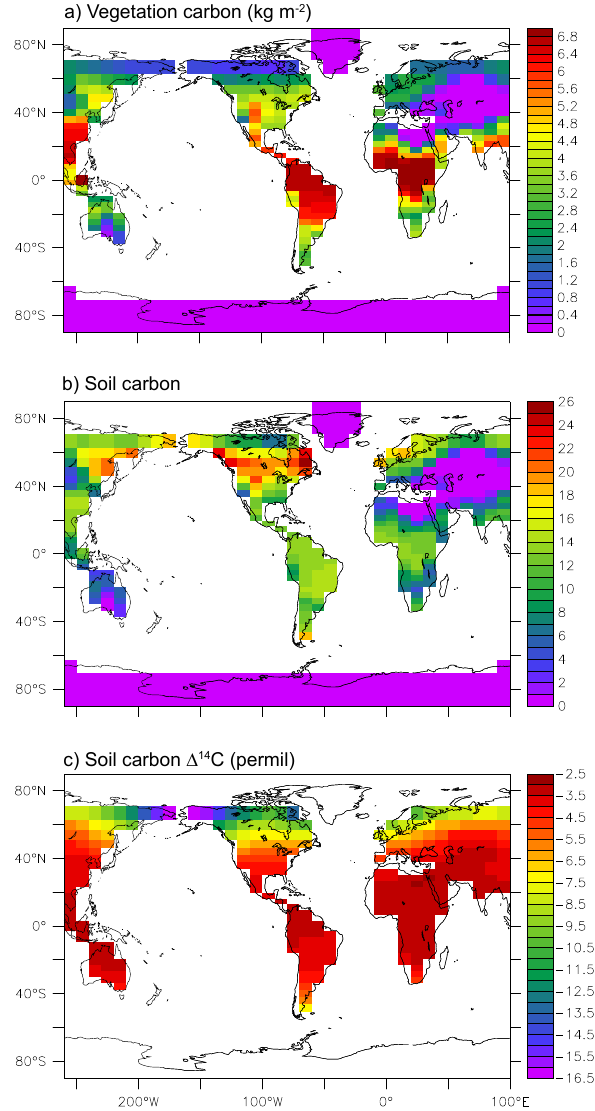
Fig. 12. Simulated annual mean terrestrial biosphere results from MESMO 2E: (a) vegetation carbon stock; (b) soil carbon stock; and (c) soil carbon 1 14